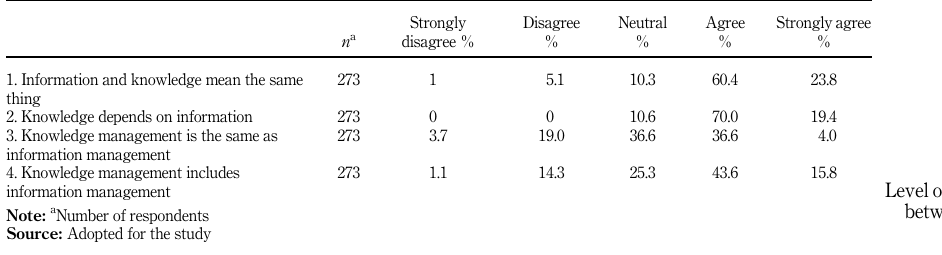
Table III. Level of